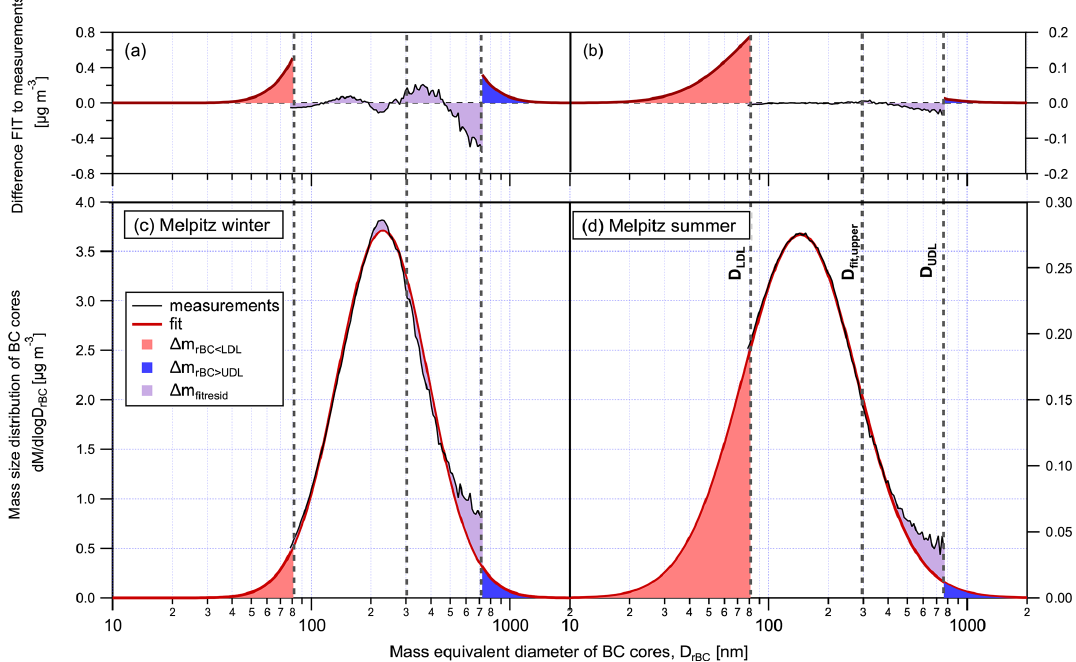
Figure 1. Approach to correct for the rBC mass outside the rBC core size range covered by the SP2 for the Melpitz winter ( a and c ) and the Melpitz summer ( b and d ) campaigns. (c) and (d) show the measured rBC mass size distribution as a function of rBC core mass equivalent diameter, including the SP2 detection limits D LDL and D UDL . The lognormal functions are fitted between D LDL and D fit , upper . The inte- grated areas of the red, purple, and blue shading correspond to (cid:49)m rBC < LDL , (cid:49)m fitresid and (cid:49)m rBC > UDL , respectively (see Sect. 2.3.5). (a) and (b) additionally show the same shading after subtraction of the measured size distribution (and measurement forced to be zero outside the SP2 detection range). The average mass size distributions of the other campaigns are represented in Fig.